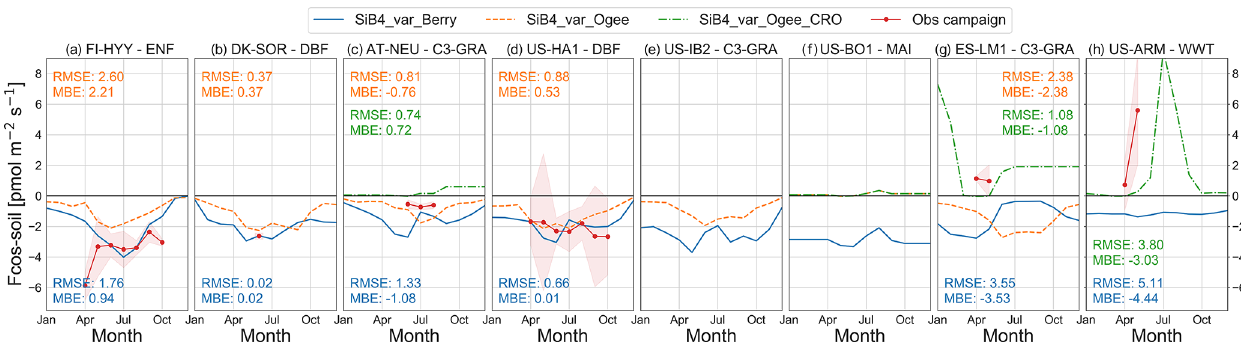
Figure 3. Comparison of COS soil flux seasonal cycles of observations (red) with different SiB4 model runs: SiB4_var_Berry (solid blue); SiB4_var_Ogee with the simulation representing the PFT type as indicated in the plot titles (dashed orange); and SiB4_var_Ogee_CRO with the simulation representing agricultural soil (Table 2) for sites AT-NEU, US-BO1, ES-LM1, and US-ARM (dash-dotted green). No in situ observations of soil COS fluxes are available for US-IB2 and US-BO1. Monthly averages are shown with the 1 σ spread around the mean for observations. The model simulations are from the same year(s) in which observations were made. Negative values indicate uptake of COS by the ecosystem, while positive values indicate COS emissions. The MBE and RMSE (pmolm − 2 s − 1 ) are given for monthly average fluxes for all model runs in their respective color. Sites are presented from high to low latitude.